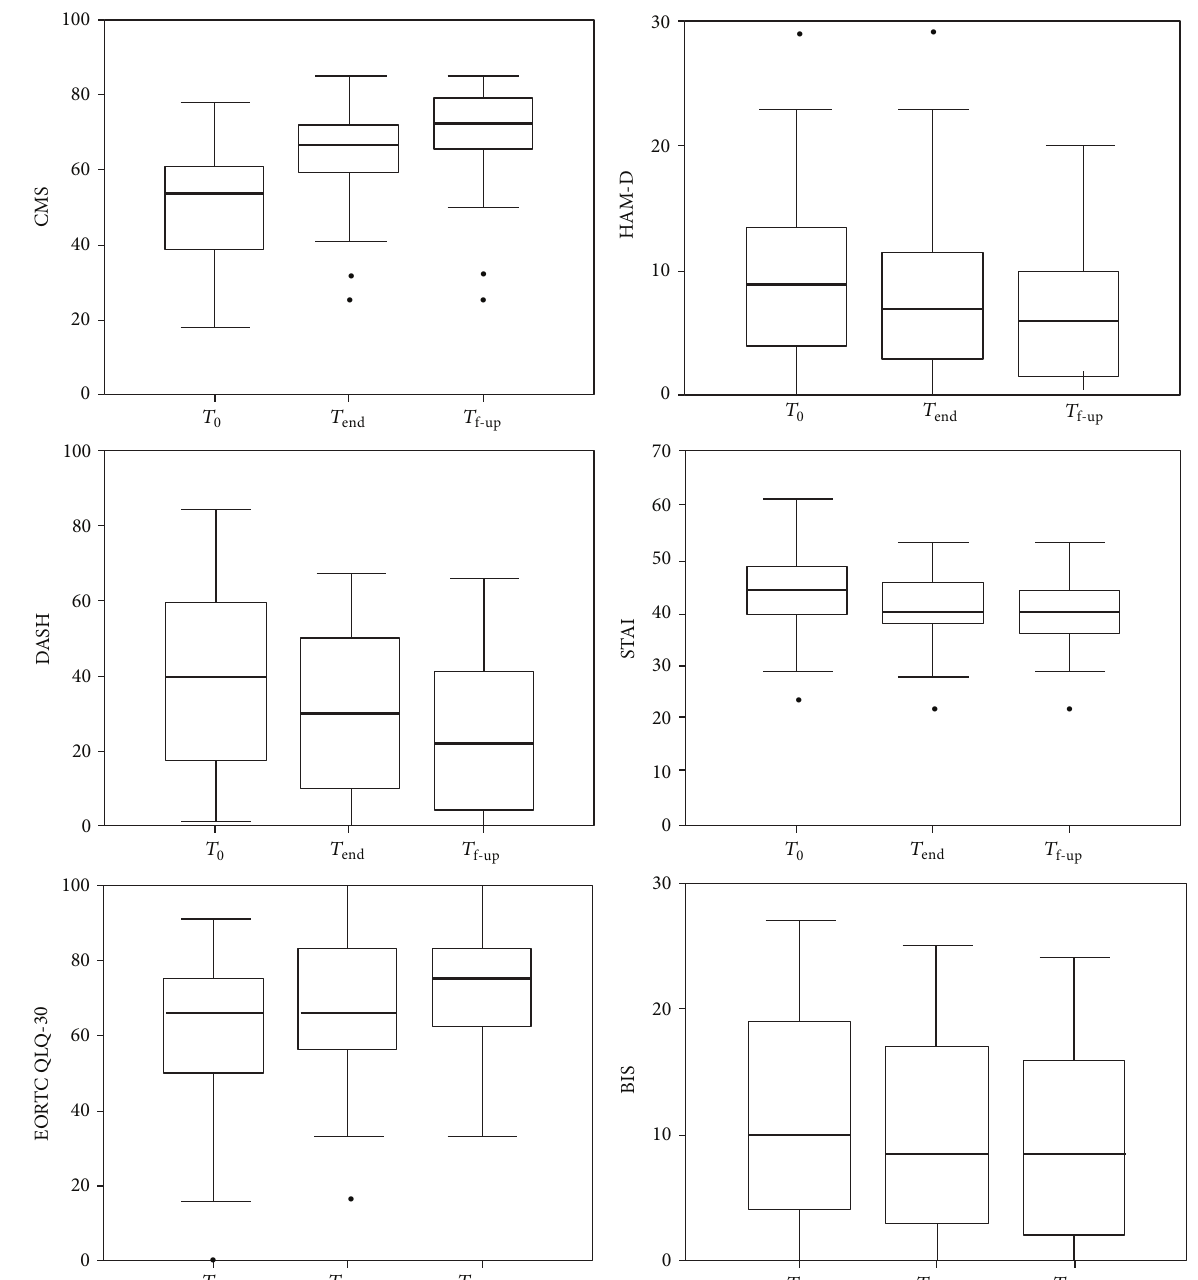
Figure 2: Box and whiskers plot of the scale-scores related to the physical and psychological features of the patients recorded at baseline (𝑇 0 ) , ) , and after three months of follow-up (𝑇 ) . Each box represents first and third quartile values together with the at end of treatment (𝑇 end f-up bold line representing the median values; whiskers represent the minimum and maximum values, and the circles are the values considerable by outliers (not excluded but analysed). CMS: Constant-Murley Score, DASH: Disabilities of the Arm, Shoulder, and Hand Questionnaire, EORTC QLQ 30: EORTC Quality of Life core questionnaire, HAM-D: Hamilton Rating Scale for Depression questionnaire, STAI: State-Trait Anxiety Inventory, and BIS: Body Image